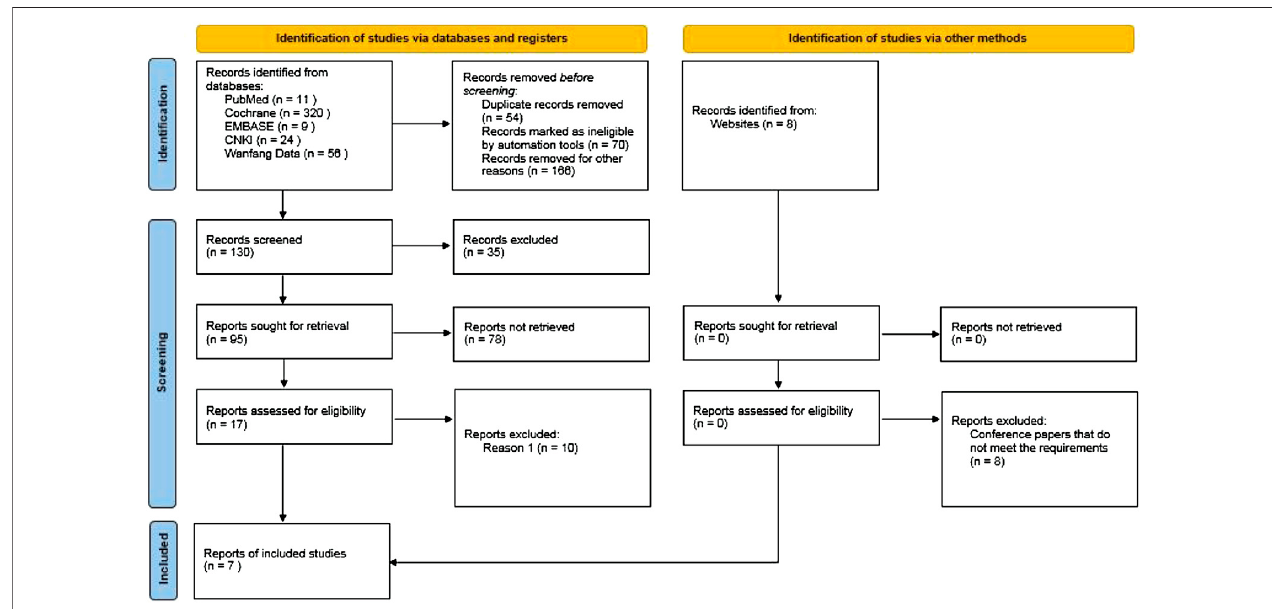
FIGURE 1 | PRISMA fl ow chart of article